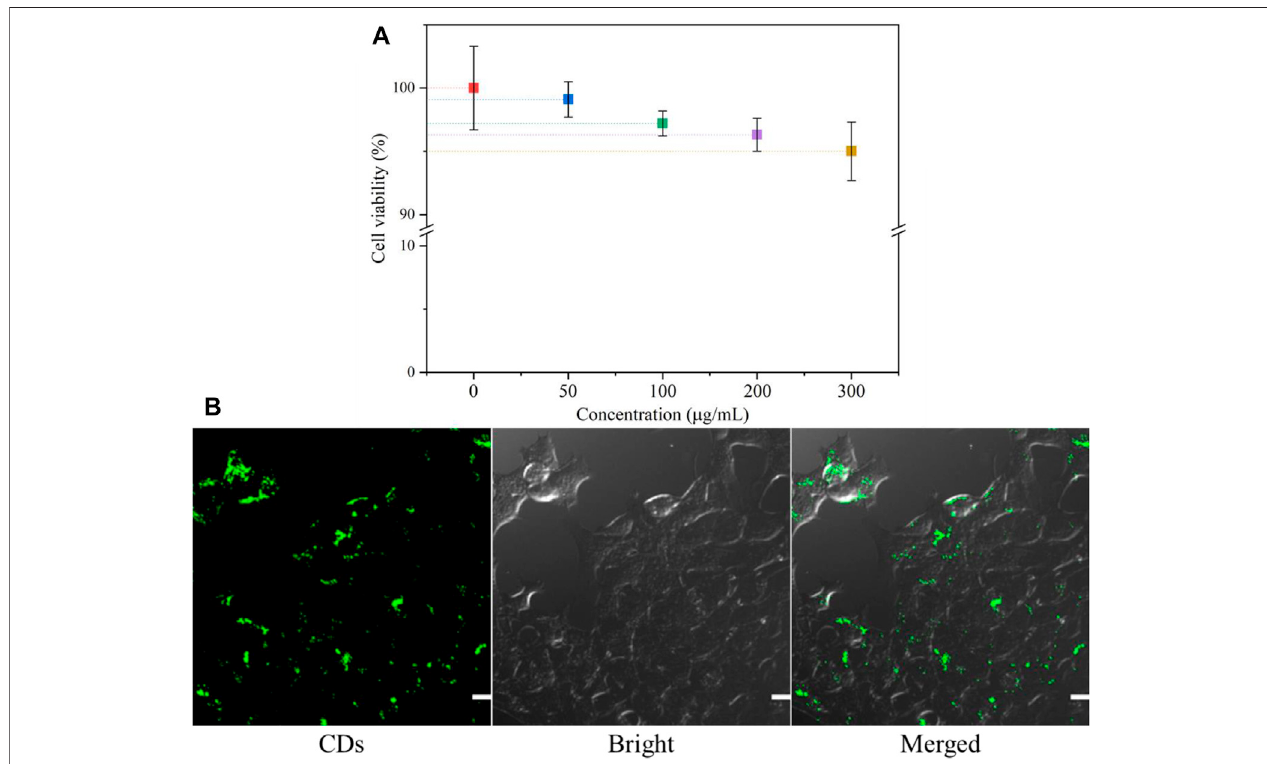
FIGURE7|(A) MTTassayresultsfortheviabilityof4T1cellsindifferentconcentrationsofCDs; (B) CLSMimagesof4T1cellsco-incubatedwithCDsfor24 h.The scale bar is 50 μ